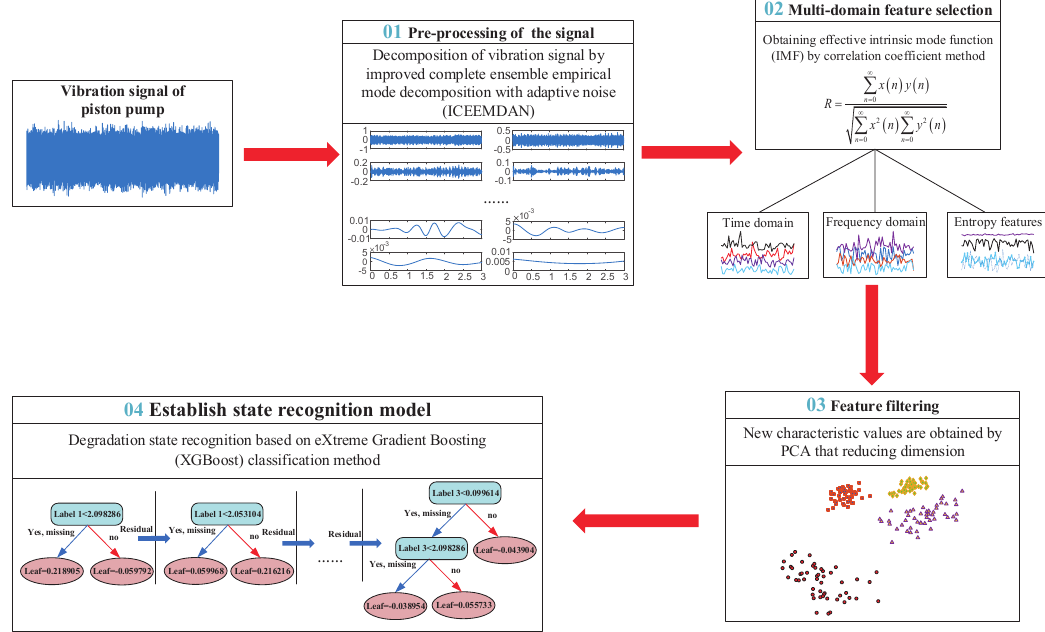
Figure 2. An overview of the proposed methods and analysis